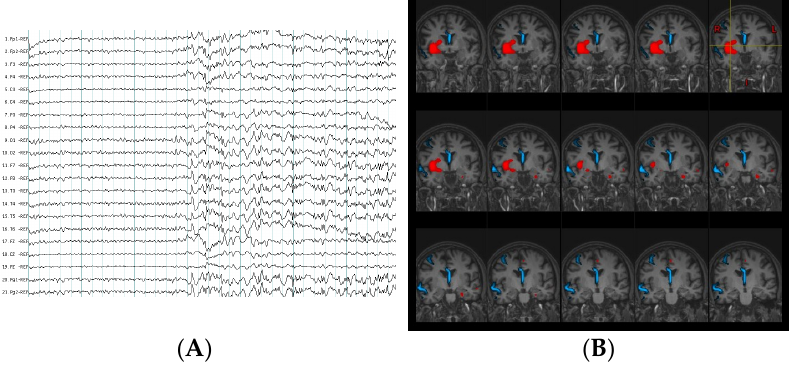
Figure 1. Multimodal evaluation in non-lesional extratemporal epilepsy patient. ( A ) Ictal scalp electroencephalography (EEG) pattern at seizure onset during habitual non aware focal motor seizures which evolved to bilateral tonic clonic seizures. Visual EEG localization did not show a clear lateralized and localized seizure onset zone. ( B ) In red, computer- aided subtraction ictal single photon emission-computed tomography (SPECT) co-registered to MRI (SISCOM) of the patient indicated localized areas of hyperperfusion (insula, inferior opercular frontal, putamen, amygdala, and anterior cingulum of the right hemisphere). In blue, estimation of ictal EEG source imaging (ESI) discharges at seizure onset also demonstrated a localize ictal source in this patient (right middle frontal gyrus, right superior temporal and middle line).